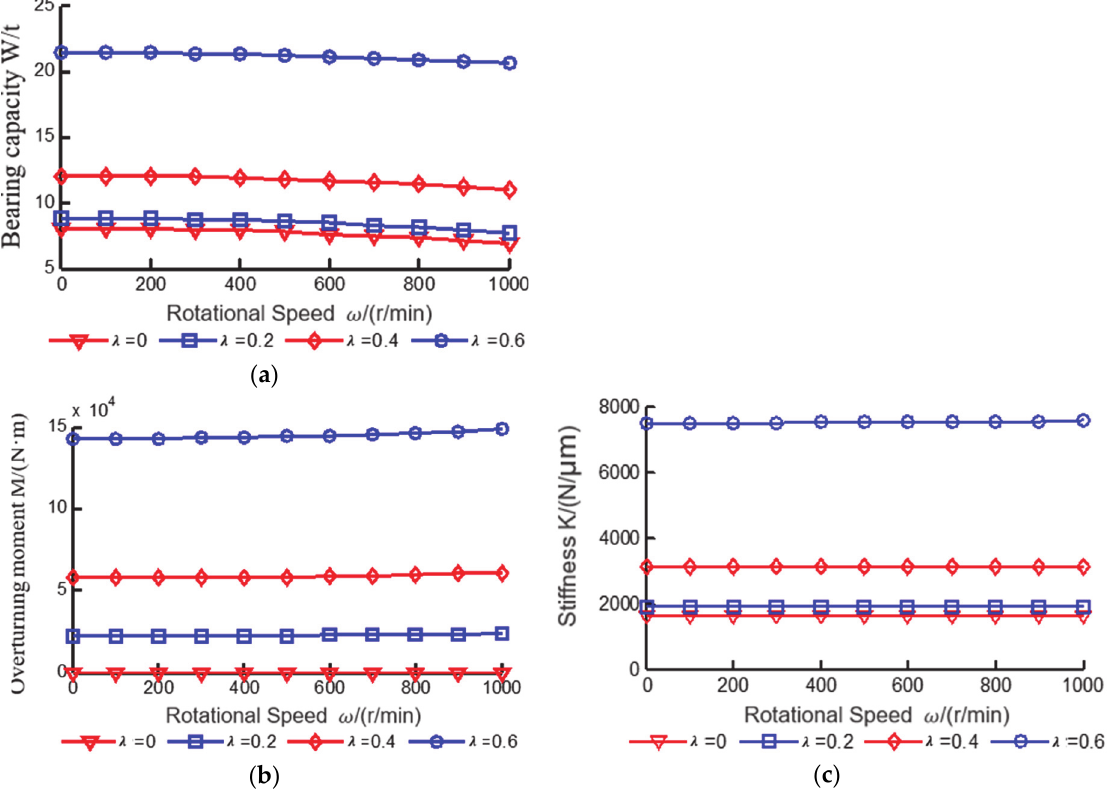
Figure 13. Influence of rotational speed on bearing characteristics. ( a ) Influence on oil film bearing capacity; ( b ) Influence on oil film overturning moment; ( c ) Influence of inclined displacement rate on oil film stiffness.